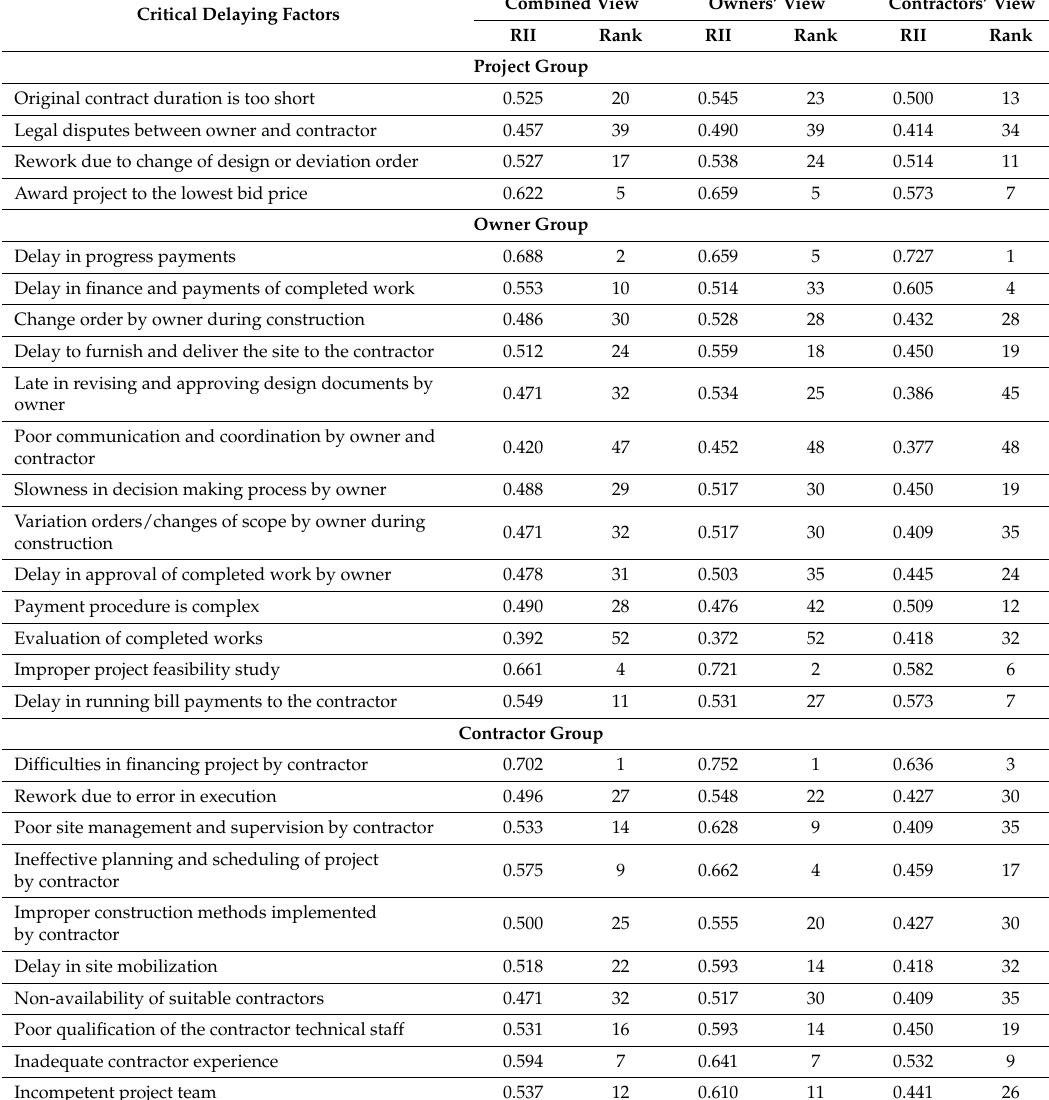
Table 3. Relative Importance Index (RII) Value and Ranking of Critical Delaying